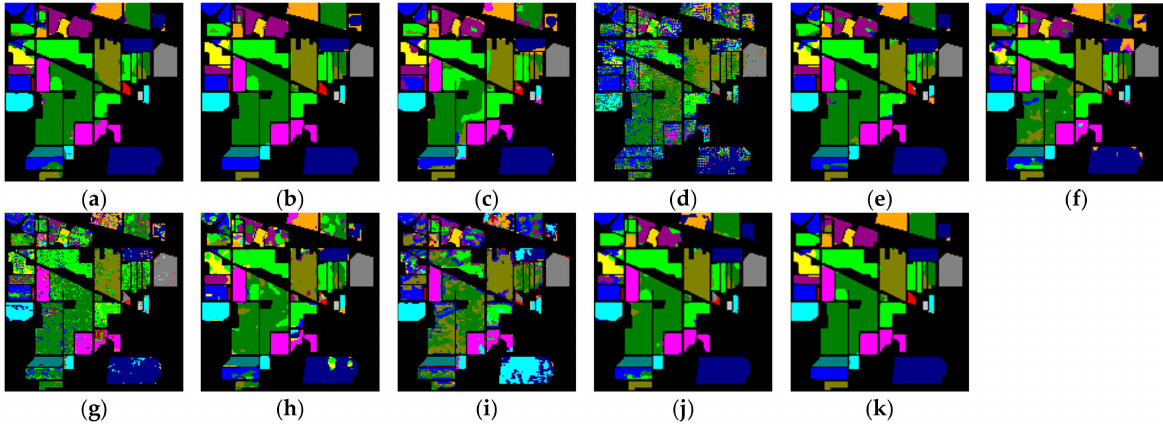
Figure 8. The overall accuracy and classification maps of different methods on IN dataset: ( a ) A2S2KResNe (92.1%); ( b ) DBDA (92.58%); ( c ) DBMA (89.95%); ( d ) PyResNet (51.03%); ( e ) SSRN (89.24%); ( f ) ViT (78.62%); ( g ) SVM (67.77%); ( h ) HybridSN (82.18%); ( i ) DCCNN (71.42%); ( j ) FDSSC (92.29%); ( k ) proposed